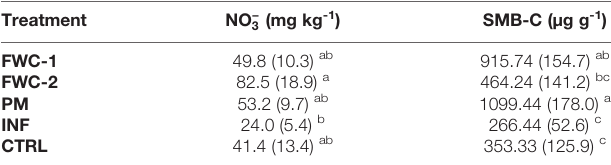
TABLE 8 | Mean values for soil nitrate and microbial biomass-carbon at 0 - 20 cm depth for all treatments (food waste composts FWC-1 and FWC-2), poultry manure (PM), inorganic nitrogen fertilizer (INF), and control (CTRL). Values with different letters (a,b,c) in the same column indicate a signi fi cant (p<0.05) difference between treatments.